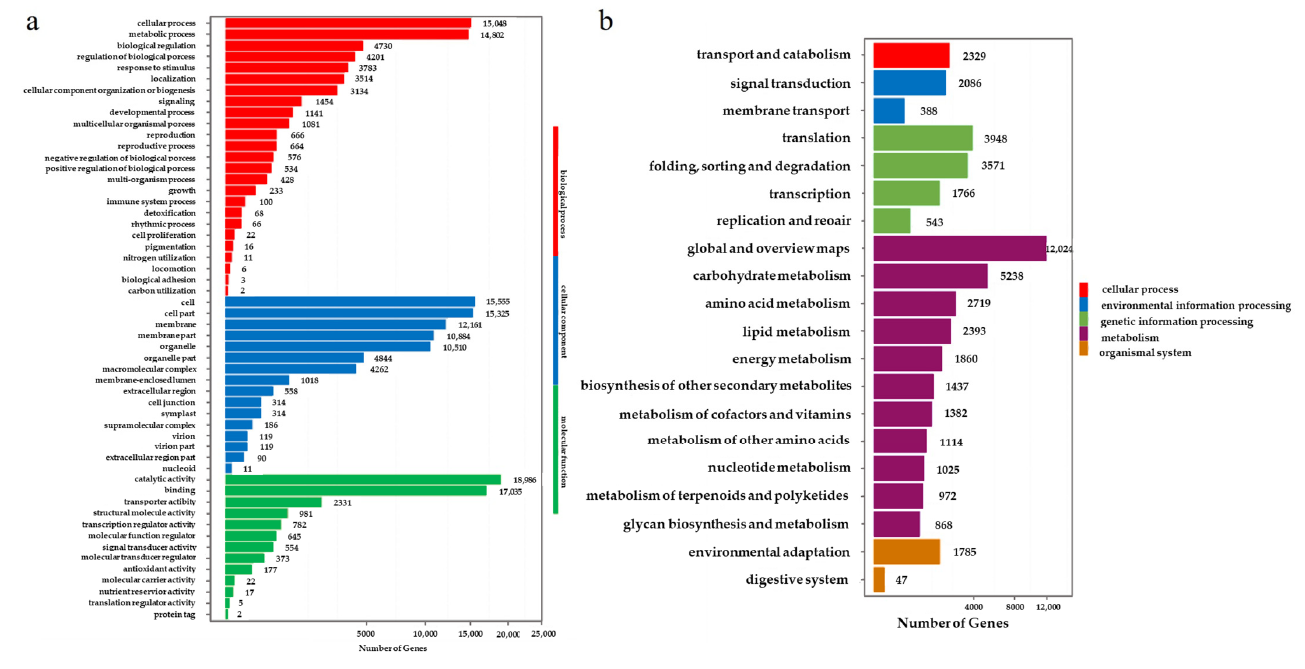
Figure 2. Functional annotation of all isoforms. ( a ) Functional distribution of GO annotation. ( b ) Functional distribution of KEGG annotation. Note: X axis represents the number of transcripts. Y axis represents the Gene Ontology or the KEGG function category.